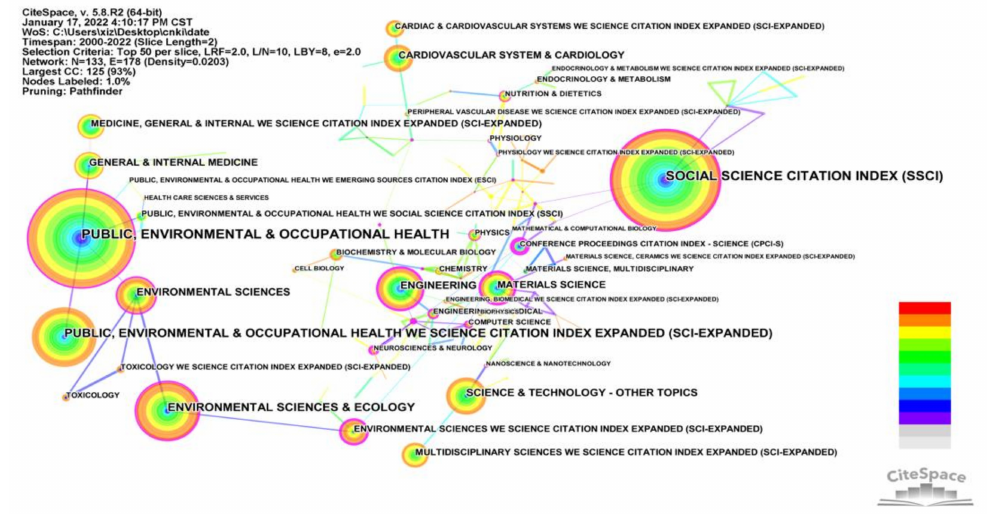
Figure 7. Knowledge map of co-occurrence